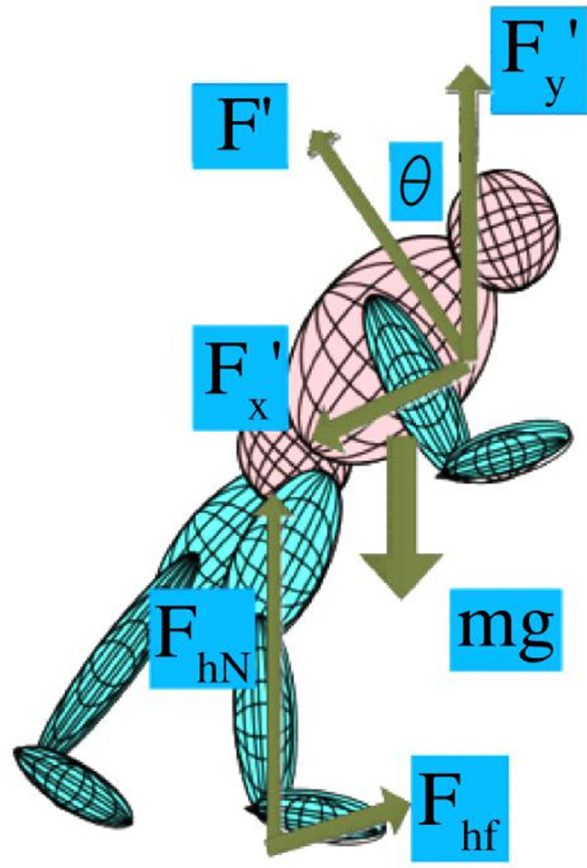
Figure 4: Static system robot force